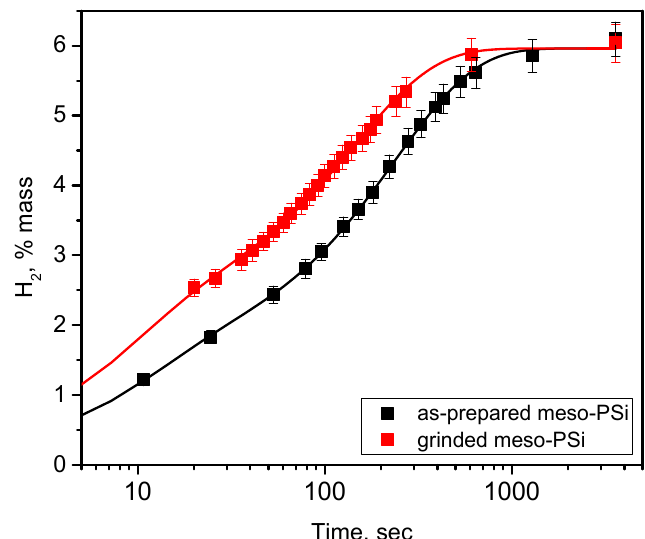
Figure 7. Kinetics of hydrogen generation depending on grinding degree of meso-PSi nanopowders. The oxidation reaction takes place in solutions of water:ethanol = 3:2 containing NH 4 OH in a concentration of 0.77 M / L. Discrete points correspond to experimentally measured values, while solid lines are the fitting functions given in Supplementary